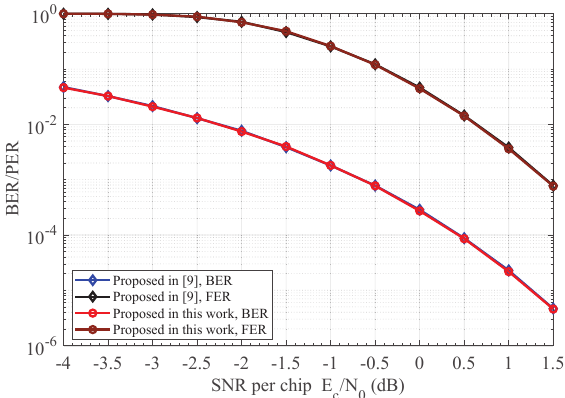
Figure 8. BER and PER comparison for the proposed receiver and the receiver in